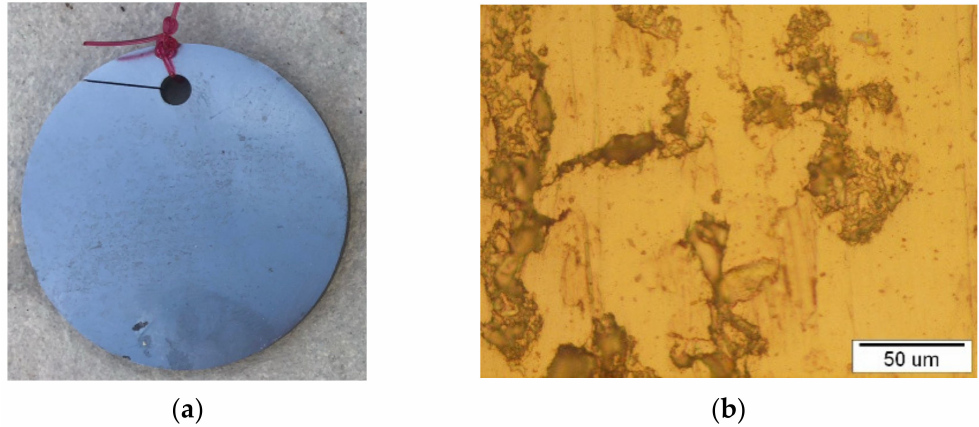
Figure 3. NiTi disc after 6 months in atmosphere: ( a ) presentation of the macro view and ( b ) representative optical microstructure.